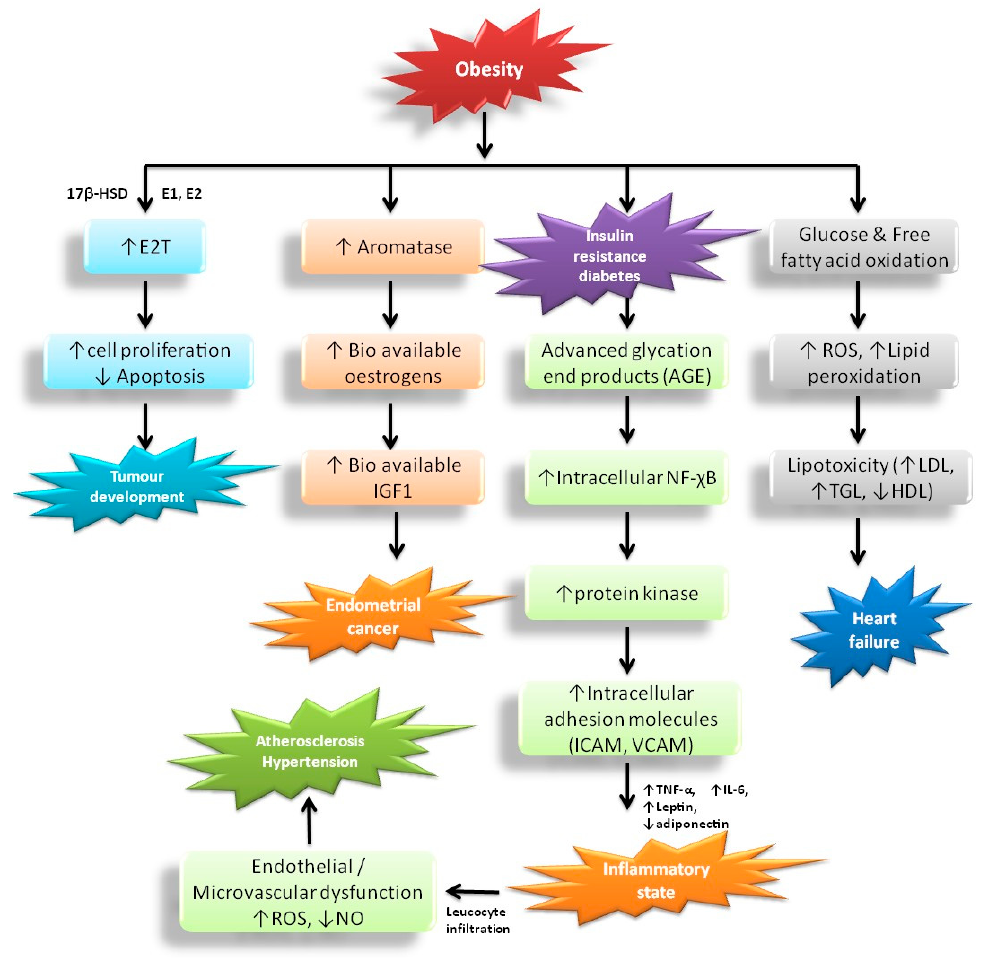
Figure 2. Physiological disorders related to obesity and its impact on human health. Endometrial cancer : Obesity elevates the threat of endometrial cancer via endocrine pathways. Elevated